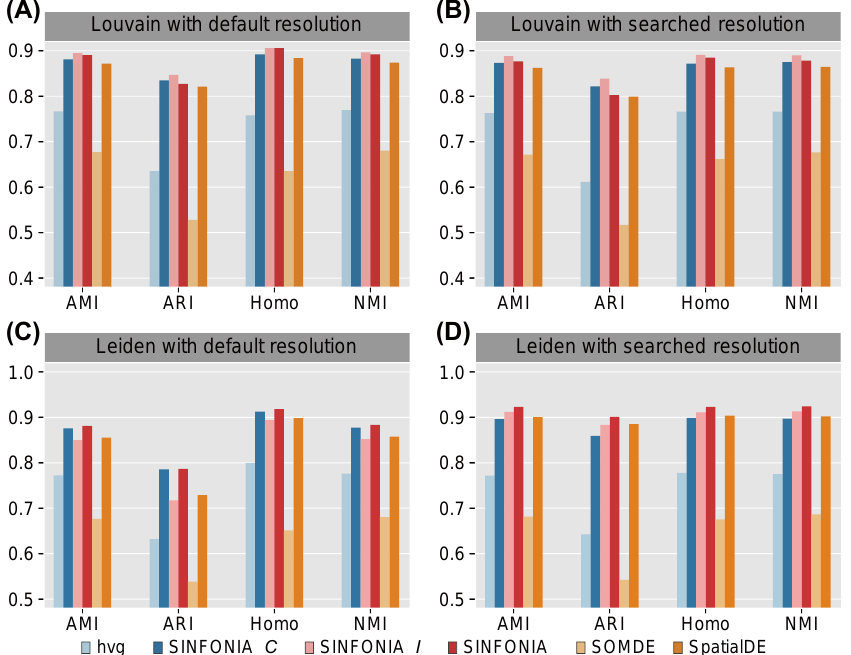
Figure 3. Louvain clustering results with ( A ) default resolution and ( B ) searched resolution on the MBC dataset. Leiden clustering results with ( C ) default resolution and ( D ) searched resolution on the MBC dataset.